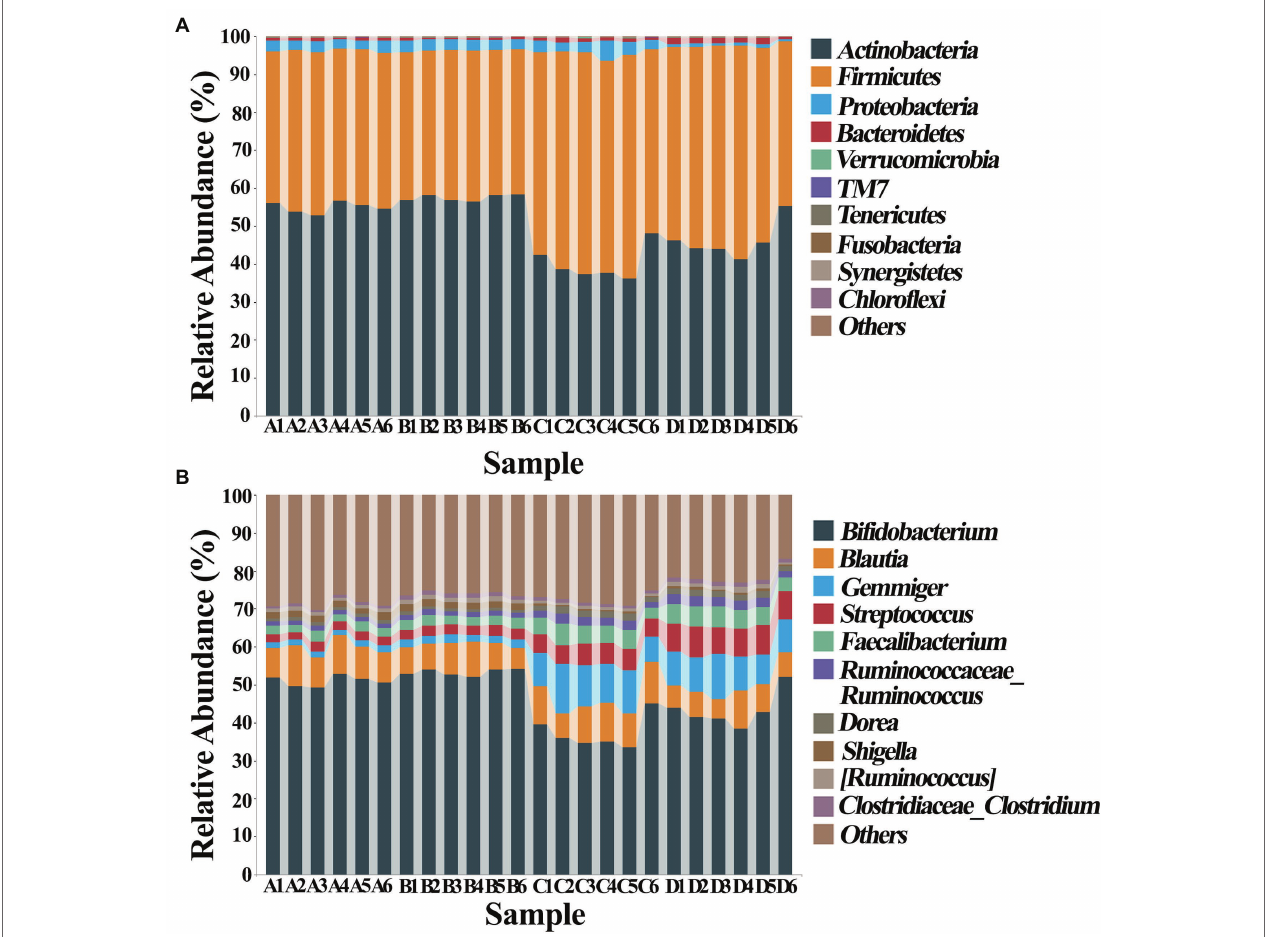
FIGURE 10 | Classification and composition diagram ( n = 6) at (A) phylum and (B) genus levels. A: Healthy; B: healthy + ZnONP; C: ADHD; and D: ADHD +